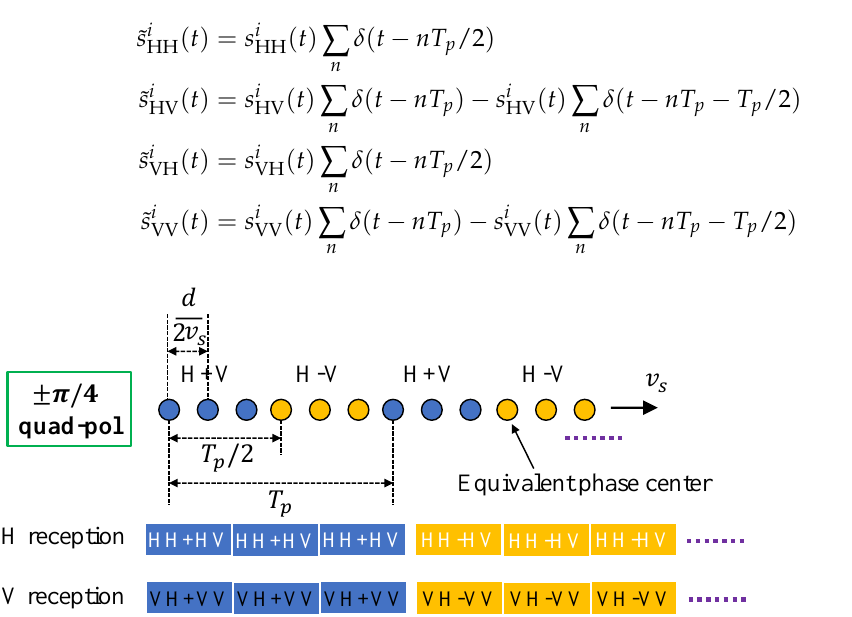
Figure 2. Spatial distribution of samples in azimuth direction from four transmit pulses separated by T p /2 for a three-channel ± π /4 quad-pol SAR systems. The circles represent equivalent phase centers separated by d